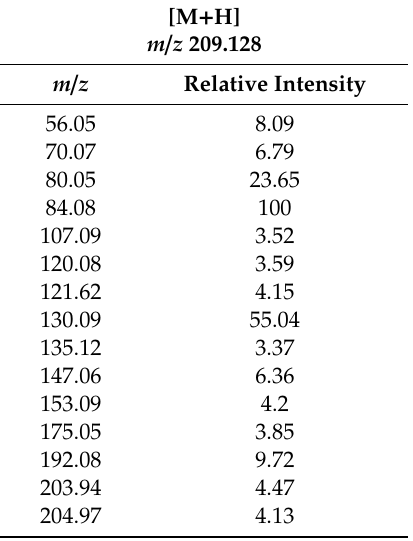
Table A2. The MS2 peak lists of the uncharacterized metabolites detected specifically in A. oligospora